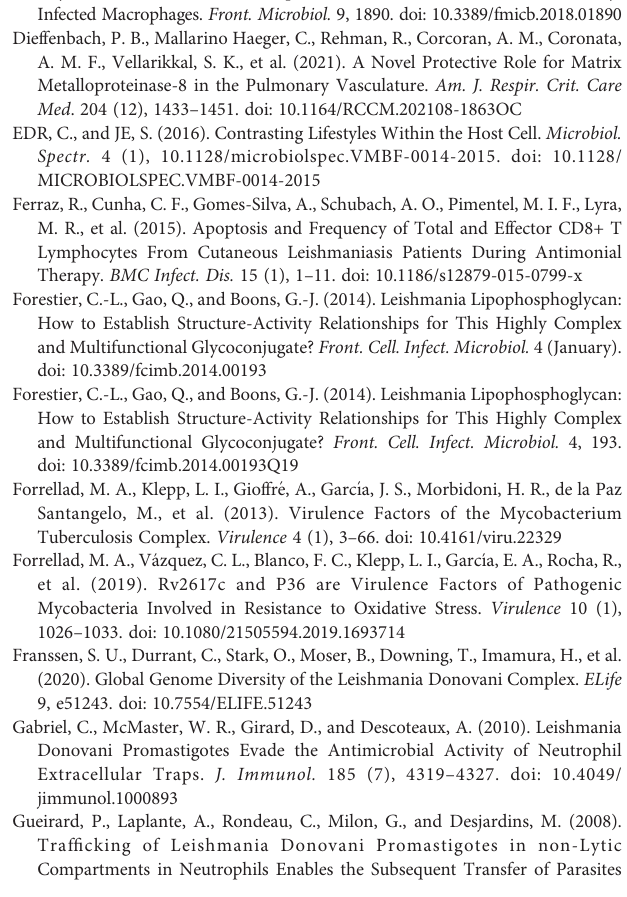
Supplementary Figure 1 | Gating strategy of human neutrophils infected with CFSE-stained L. infantum. Parasites pre-stained with Carboxy fl uorescein Succinimidyl Ester (CFSE) wereused toinfect Neutrophils for 3h. (A) Cellswere fi rst selected in a sideward scatter channel (SSC) vs. forward scatter channel (FSC) plot, thensingletswereidenti fi edbyFSC-Hvs.FSC-Aplotforexclusionofdebrisandlive cells were selected based on negative Fixable Viability Dye staining. Subsequently, the gating of infected cells was set on the positive CFSE population. (B) Individual plots showing representative populations of neutrophils uninfected, or infected with L. infantum WT, Δ lpg1 or Δ lpg1+LPG1,